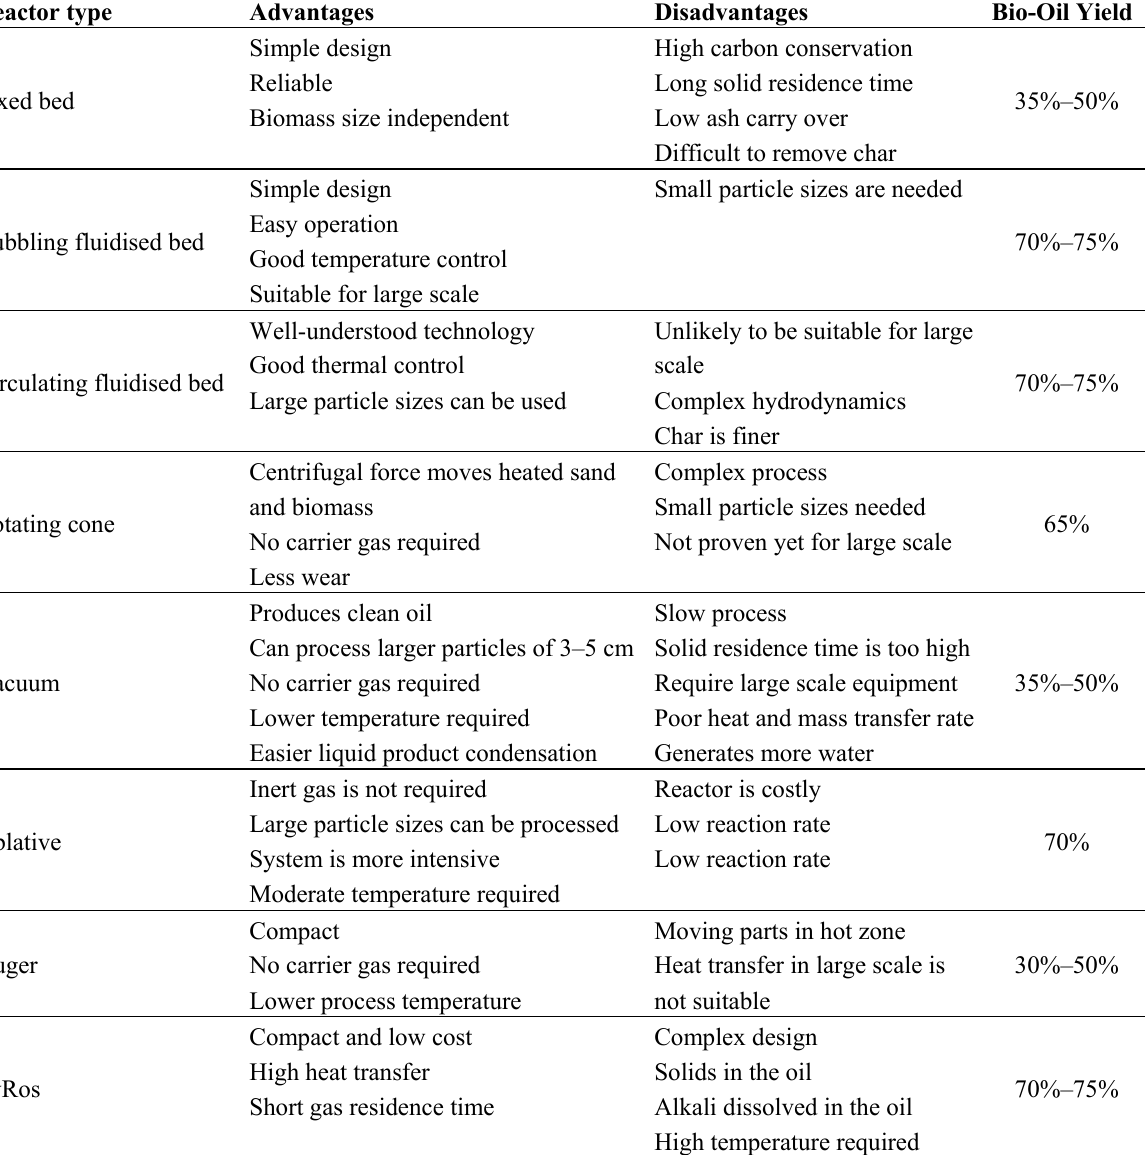
Table 14. Advantages, disadvantages and bio-oil yield of different pyrolysis reactors